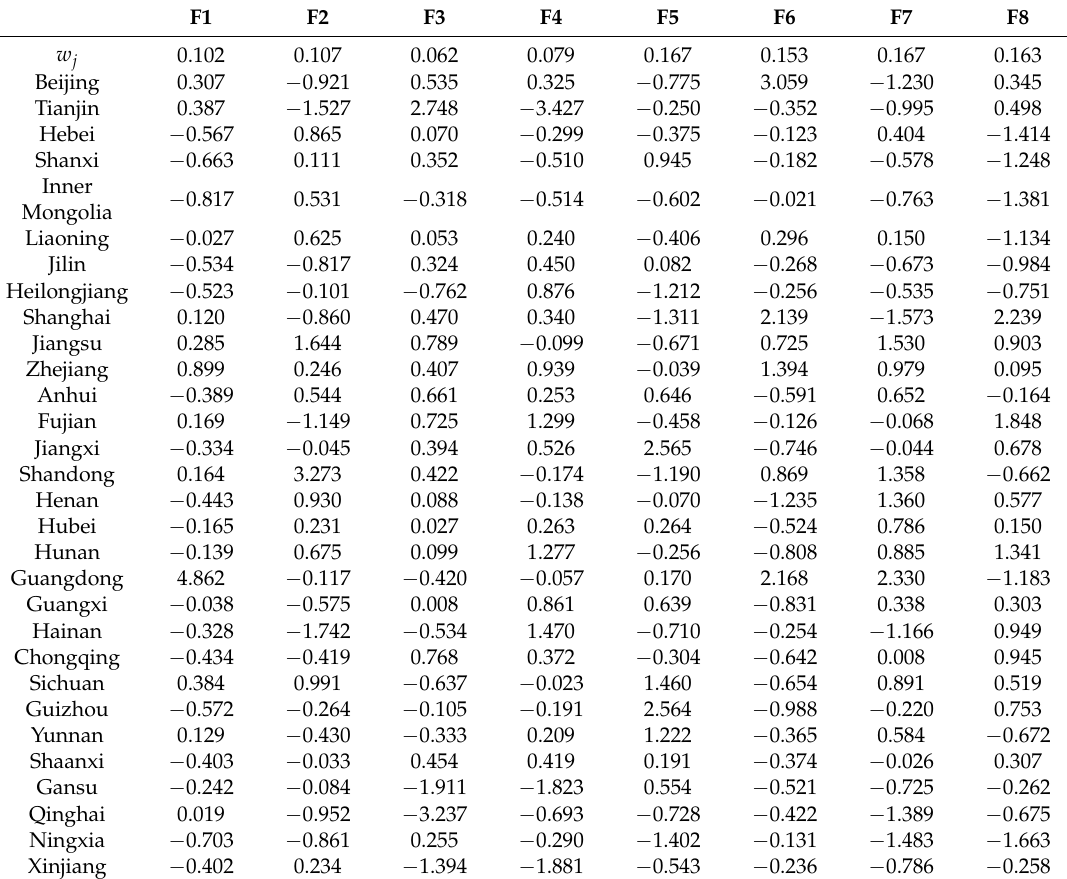
Table 5. Decision Matrix and Entropy Weight of Principal